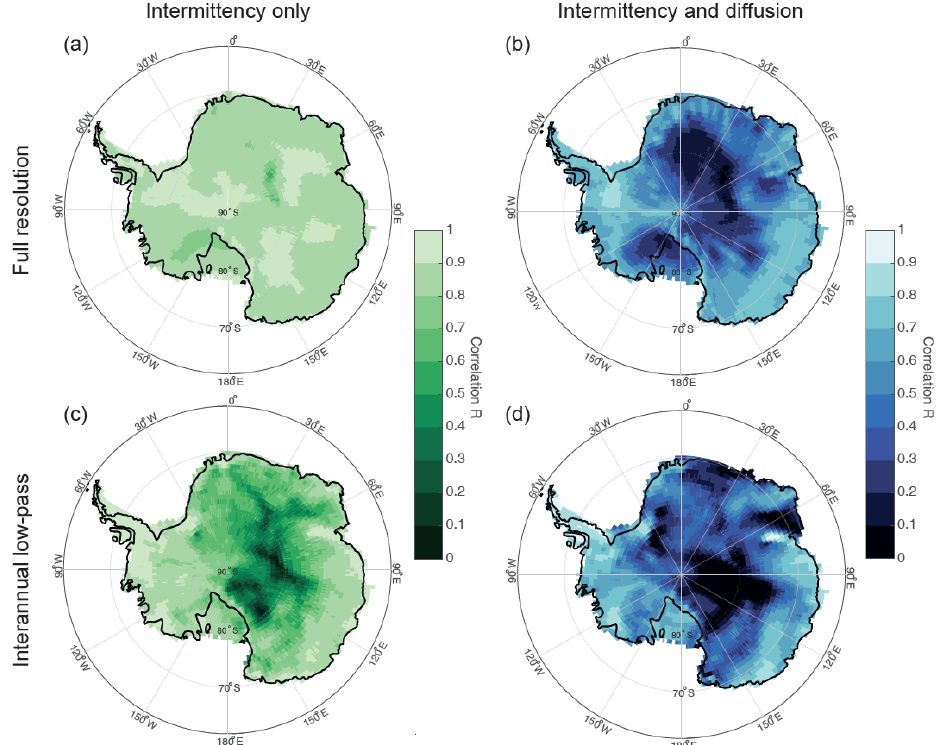
Figure 3. Maps showing the correlation between the climatic signal and perfectly dated virtual cores: (a, c) precipitation intermittency only (green); (b, d) precipitation intermittency and diffusion (blue). The top panels (a) and (b) present the correlation using the complete time series, while the bottom panels (c) and (d) show the correlation for the time series smoothed with a 2-year running mean filter.